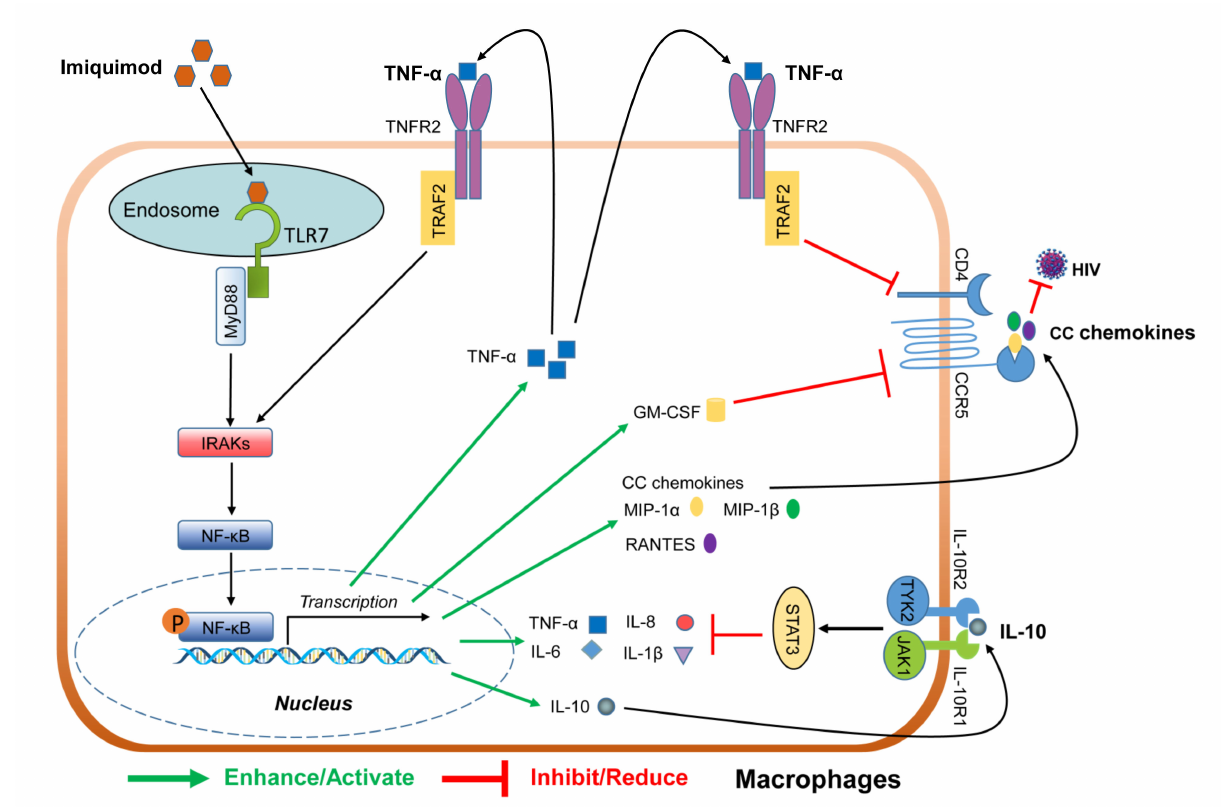
Figure 8. Schematic diagram of mechanisms for imiquimod-mediated HIV inhibition in macrophages. Through the activation of the NF- κ B signaling pathway by binding to TLR7, imiquimod induces CC chemokines (MIP-1 α , MIP-1 β , and RANTES), TNF- α , IL-6, IL-1 β , IL-8, and IL-10. As the natural ligands for HIV entry co-receptor CCR5, the CC chemokines can inhibit HIV entry into macrophages. Through binding to TNF receptor 2 (TNFR2), TNF- α inhibits the CD4 and CCR5 expression. In addition, TNF- α can induce the CC chemokines through binding to TNFR2 and activating the NF- κ B signaling pathway. These combined activities result in the blocking of HIV entry into macrophages by imiquimod. As a potent anti-inflammatory cytokine, IL-10 can counteract the adverse effect of the pro-inflammatory cytokines on HIV infection and inhibit HIV replication. Therefore, it is likely that imiquimod-induced IL-10 compromises the stimulatory effects of the pro-inflammatory cytokines (TNF- α , IL-6, IL-1 β , and IL-8) on HIV infection/replication in